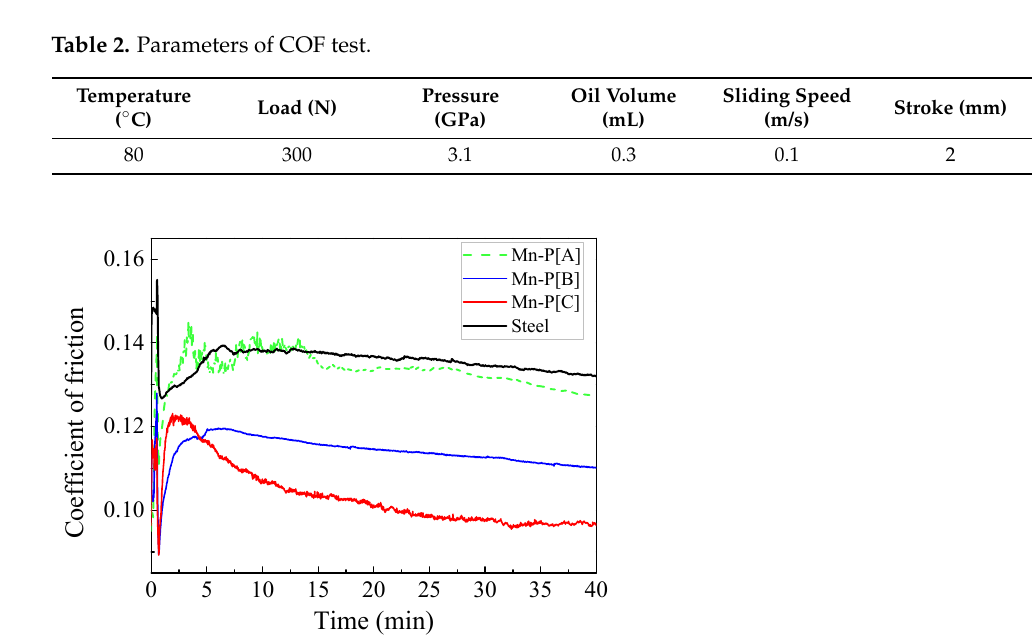
Figure 3. ( a ) The average nanoindentation depth; ( b ) The elastic modulus.